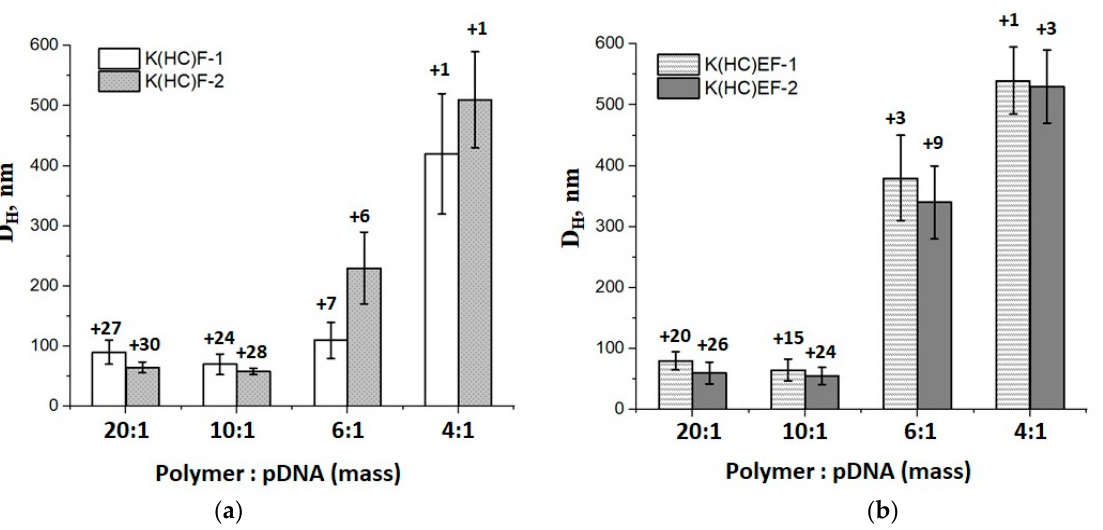
Figure 5. Hydrodynamic diameters and ζ -potential values (above the bars on histograms) for cross- linked pDNA delivery systems obtained at various polypeptide:pDNA mass ratios for two kinds of polypeptides with different cysteine content: ( a ) K(HC)F-1 and K(HC)F-2; ( b ) K(HC)EF-1 and K(HC)EF-2.